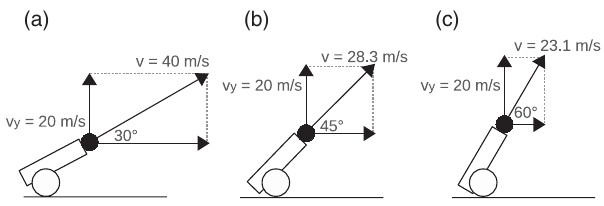
FIG. 8. Pictures from one of the problems labeled with upward-pointing triangles ( 4 ) in Fig. 4. The vertical component of the initial velocity is always 20 m = s in this problem. The problem is adapted from Ref. [4].